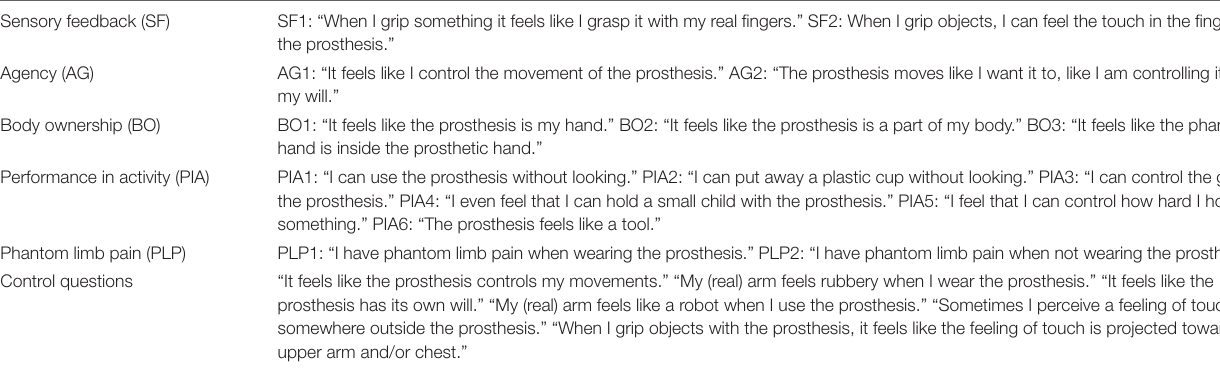
TABLE 2 | Individual questions included in questionnaire and grouped according to